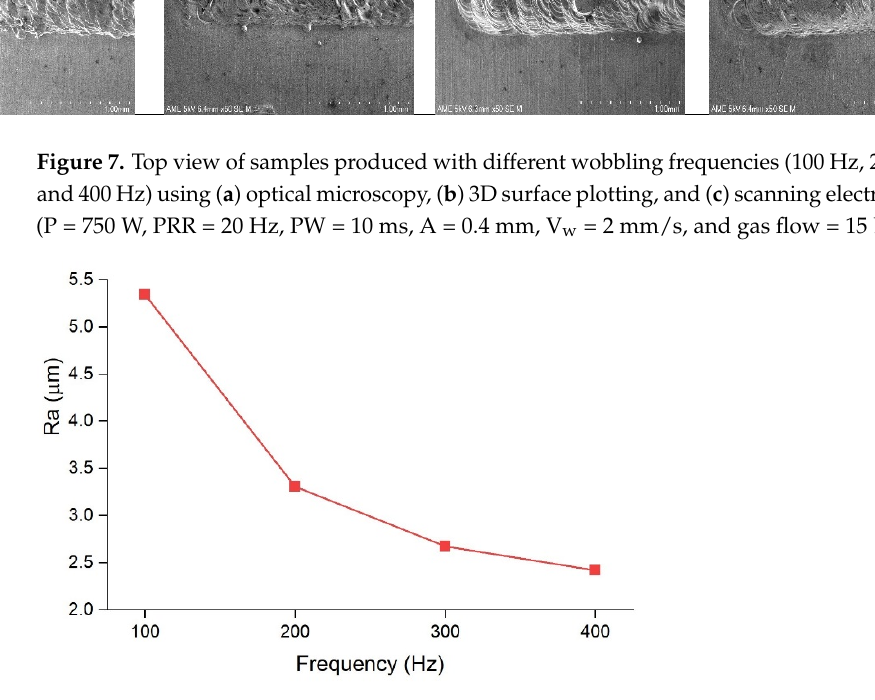
Figure 8. Roughness value (R a ) obtained along the centre line of the welds for 100 Hz, 200 Hz, 300